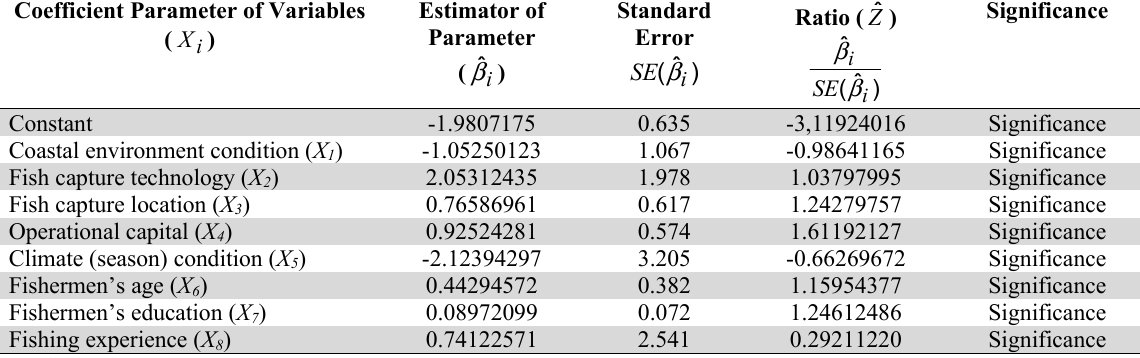
Coefficient Parameter and Standard Error